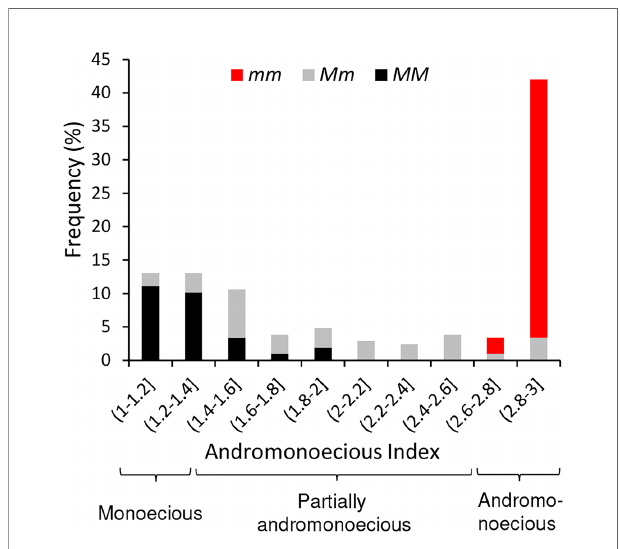
FIGURE 2 | Frequency distribution of Andromonoecious Index (AI) in 207 accessions of watermelon. Bar colors indicate the genotype of accessions for the M ( monoecious ) and m ( andromonoecious ) alleles of CitACS4 gene. Given accessions were initially genotyped as a bulk, the Mm accessions are those having both M and m alleles, but plants of those accessions were proved to be MM , Mm , or